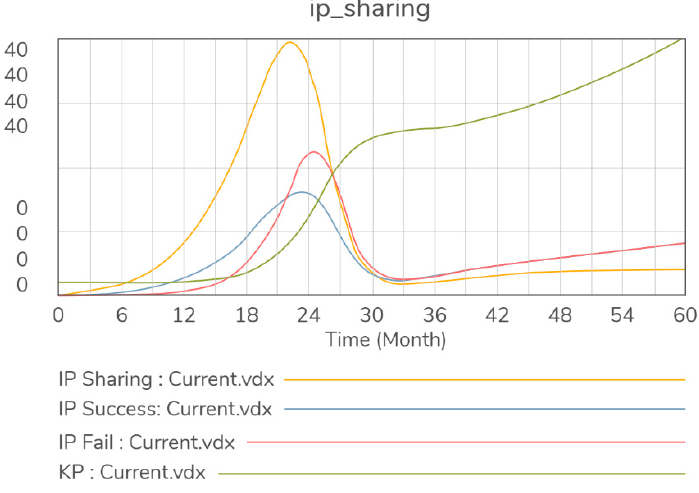
Figure 6. The OI simulation with OI